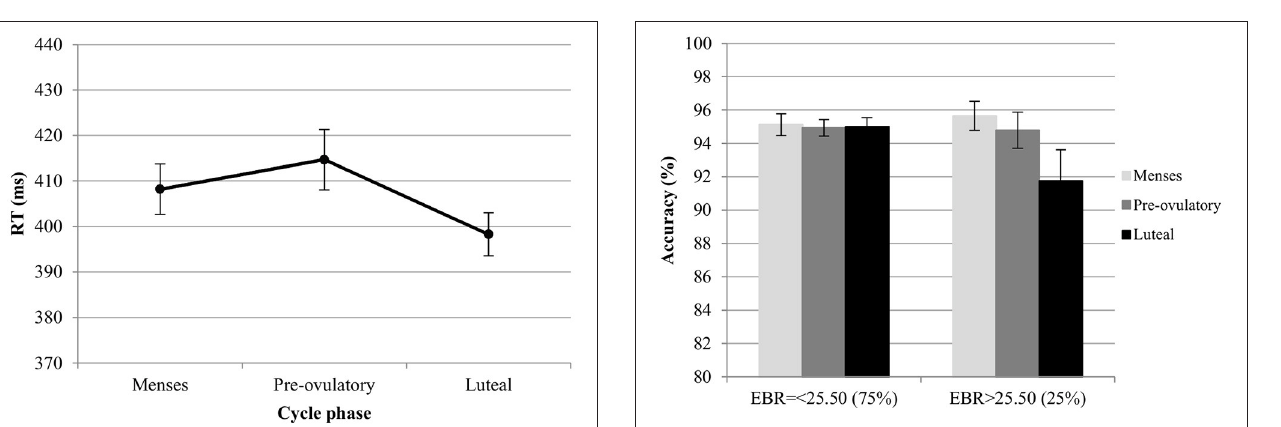
FIGURE 5 | Reaction time (RT) for the Stroop word along the menstrual cycle. Responses were significantly faster in the luteal phase compare to menses and pre-ovulatory phase.